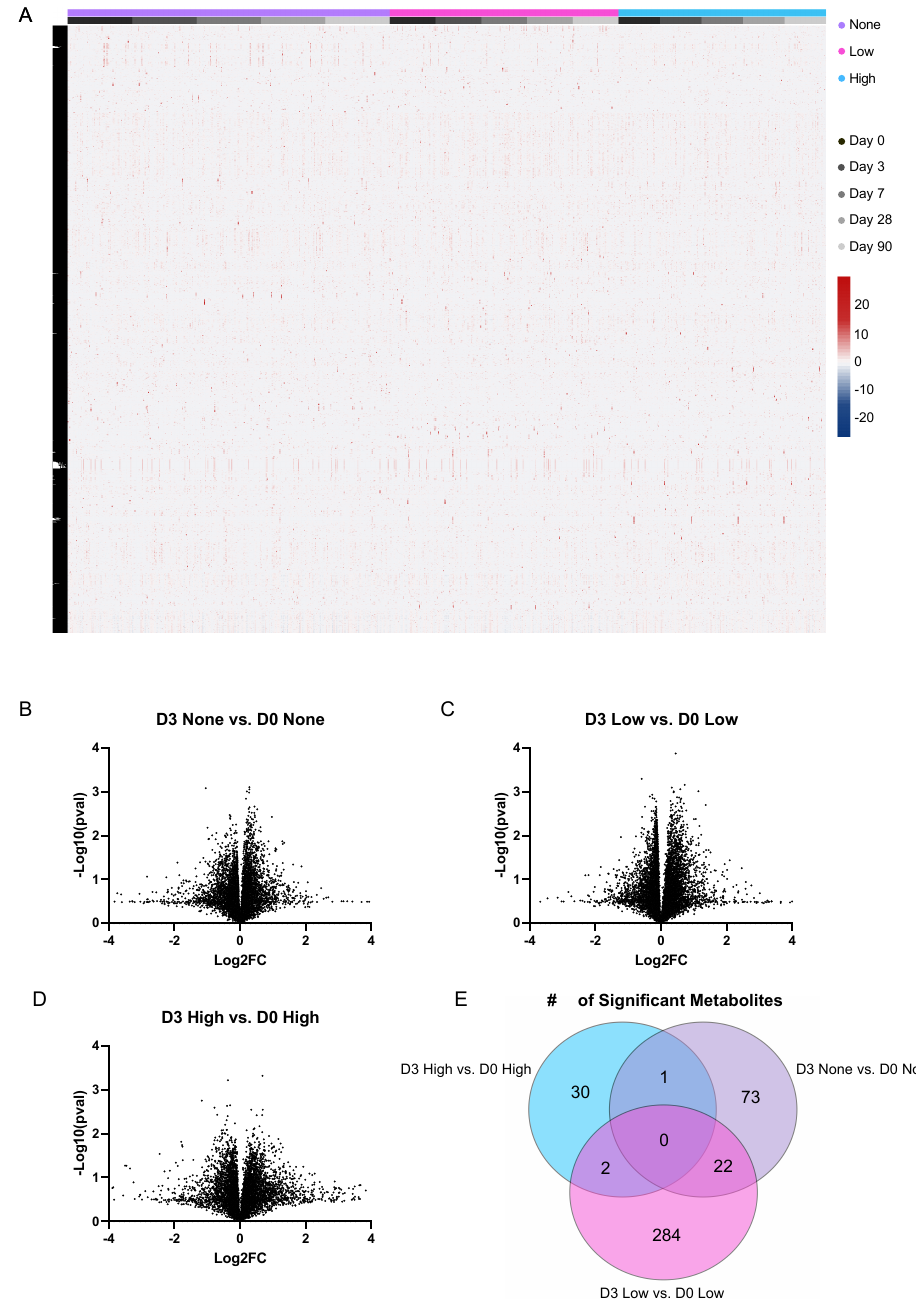
Figure 2. Summary of metabolomics data and subject response by seroconversion. ( A ) Overall semi- supervised hierarchical clustering for the metabolomics analysis; n = 895 samples analyzed with the relative quantification of 15,903 putatively identified metabolites. ( B – D ) Volcano plot representation of subject-specific metabolite fold change between Day 3 post-vaccination vs. Day 0 pre-vaccination. The x-axis represents the fold change and Log2, while the Y-axis represents statistical significance (t- test, two-tailed, equal-variance, uncorrected). ( E ) Venn diagram of overlapping significant metabolites between the three D3 vs. D0 comparisons of the High-, Low-, and None-responders,